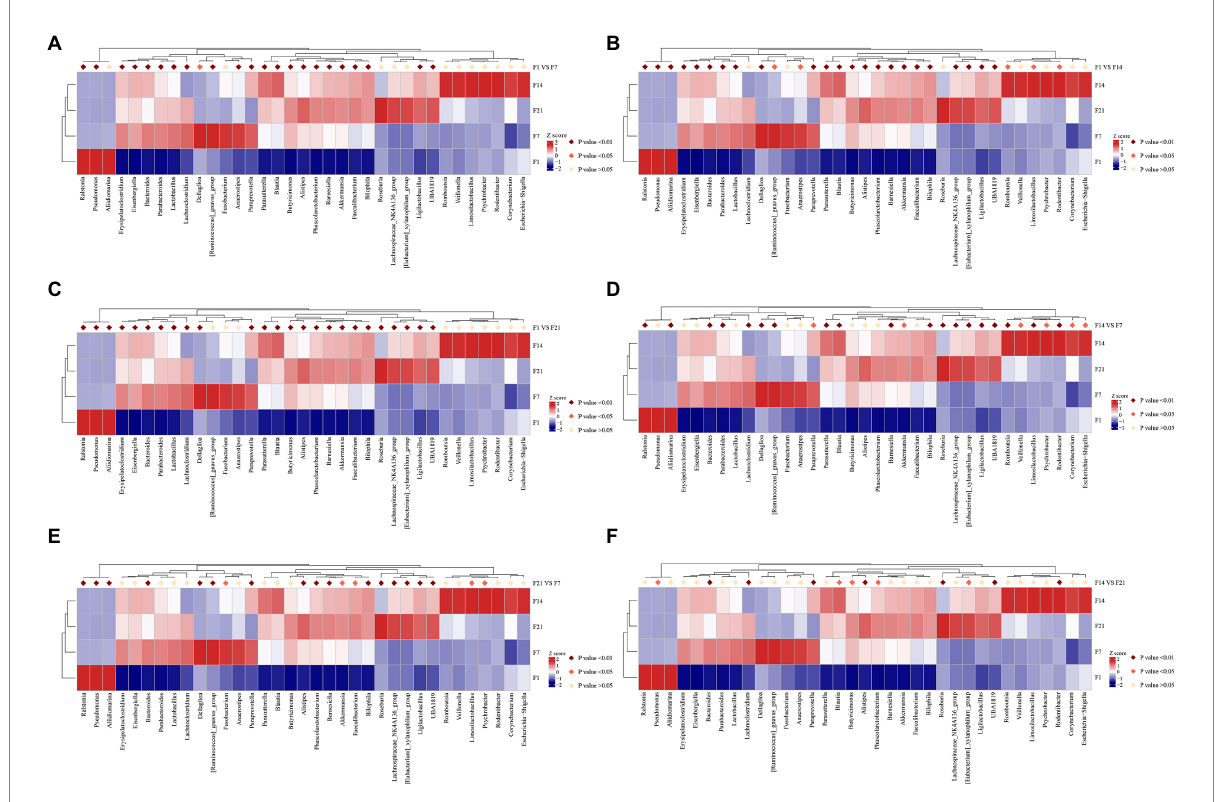
FIGURE 5 F1, day 1 of FMT; F7, day 7 of FMT; F14, day 14 of FMT; F21, day 21 of FMT; (A) F1 VS F7, Analysis of the intergroup differences on the day 1 and 7 of fecal microbiota transplantation; (B) F1 VS F14, Analysis of the intergroup differences on the day 1 and 14 of fecal microbiota transplantation; (C) F1 VS F21, Analysis of the intergroup differences on the day 1 and 21 of fecal microbiota transplantation; (D) F7 VS F14, Analysis of the intergroup differences on the day 7 and 14 of fecal microbiota transplantation; (E) F7 VS F21, Analysis of the intergroup differences on the day 7 and 21 of fecal microbiota transplantation; (F) F14 VS F21, Analysis of the intergroup differences on the day 14 and 21 of fecal microbiota transplantation. MetaStat analysis of the intergroup differences at the genus level of GF mice. * p ≤ 0.05, ** p ≤ 0.01. GF,